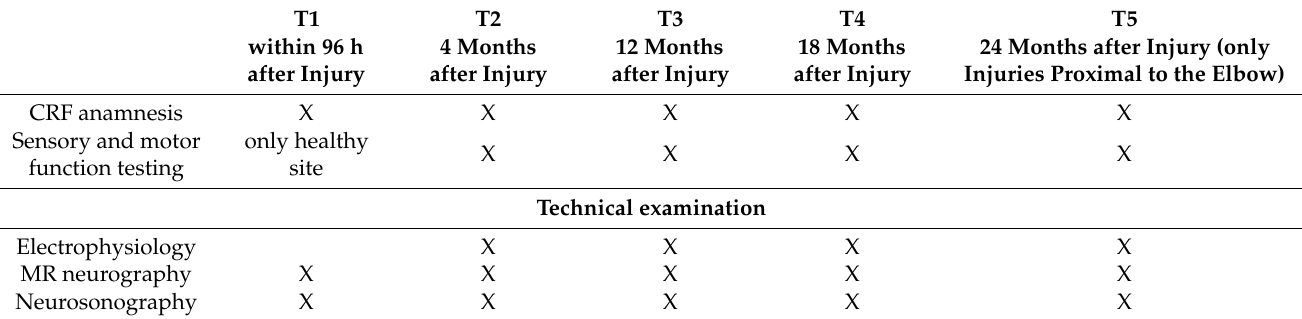
Table 2. Times of clinical and technical examinations for patients with nerve